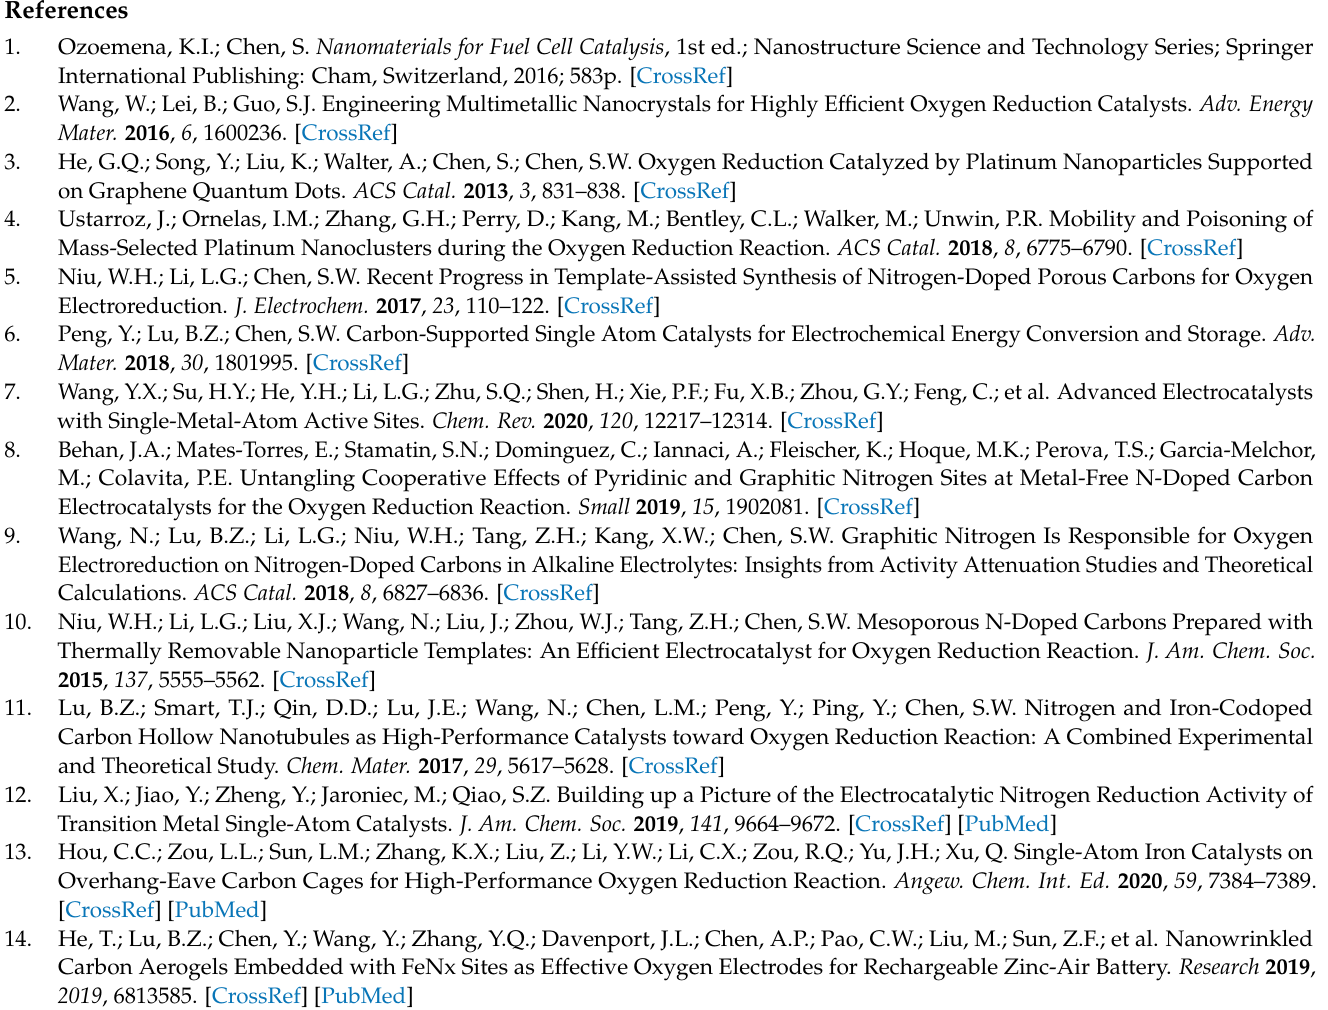
Figure S4: High-resolution scans of the (a) C 1s, (b) N 1s, and (c) Fe 2p electrons of Fe-NCF; Figure S5: High-resolution XPS scans of the (a) C 1s and (b) N 1s electrons of NCF; Table S1: Elemental compositions of the sample series from XPS measurements; Table S2: Binding energies of Fe and Ni in the sample series from XPS